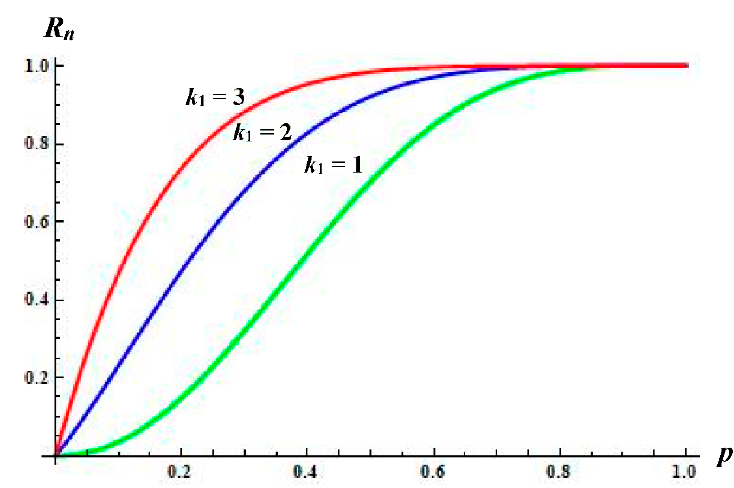
Figure 2. The reliability polynomial of the linear consecutive- k 1 and 3-out-of-6 systems ( k 1 = 1,2,3). Furthermore, in order to shed light on the influence of parameter n over the reliability of the with common parameters k 1 and k 2 .